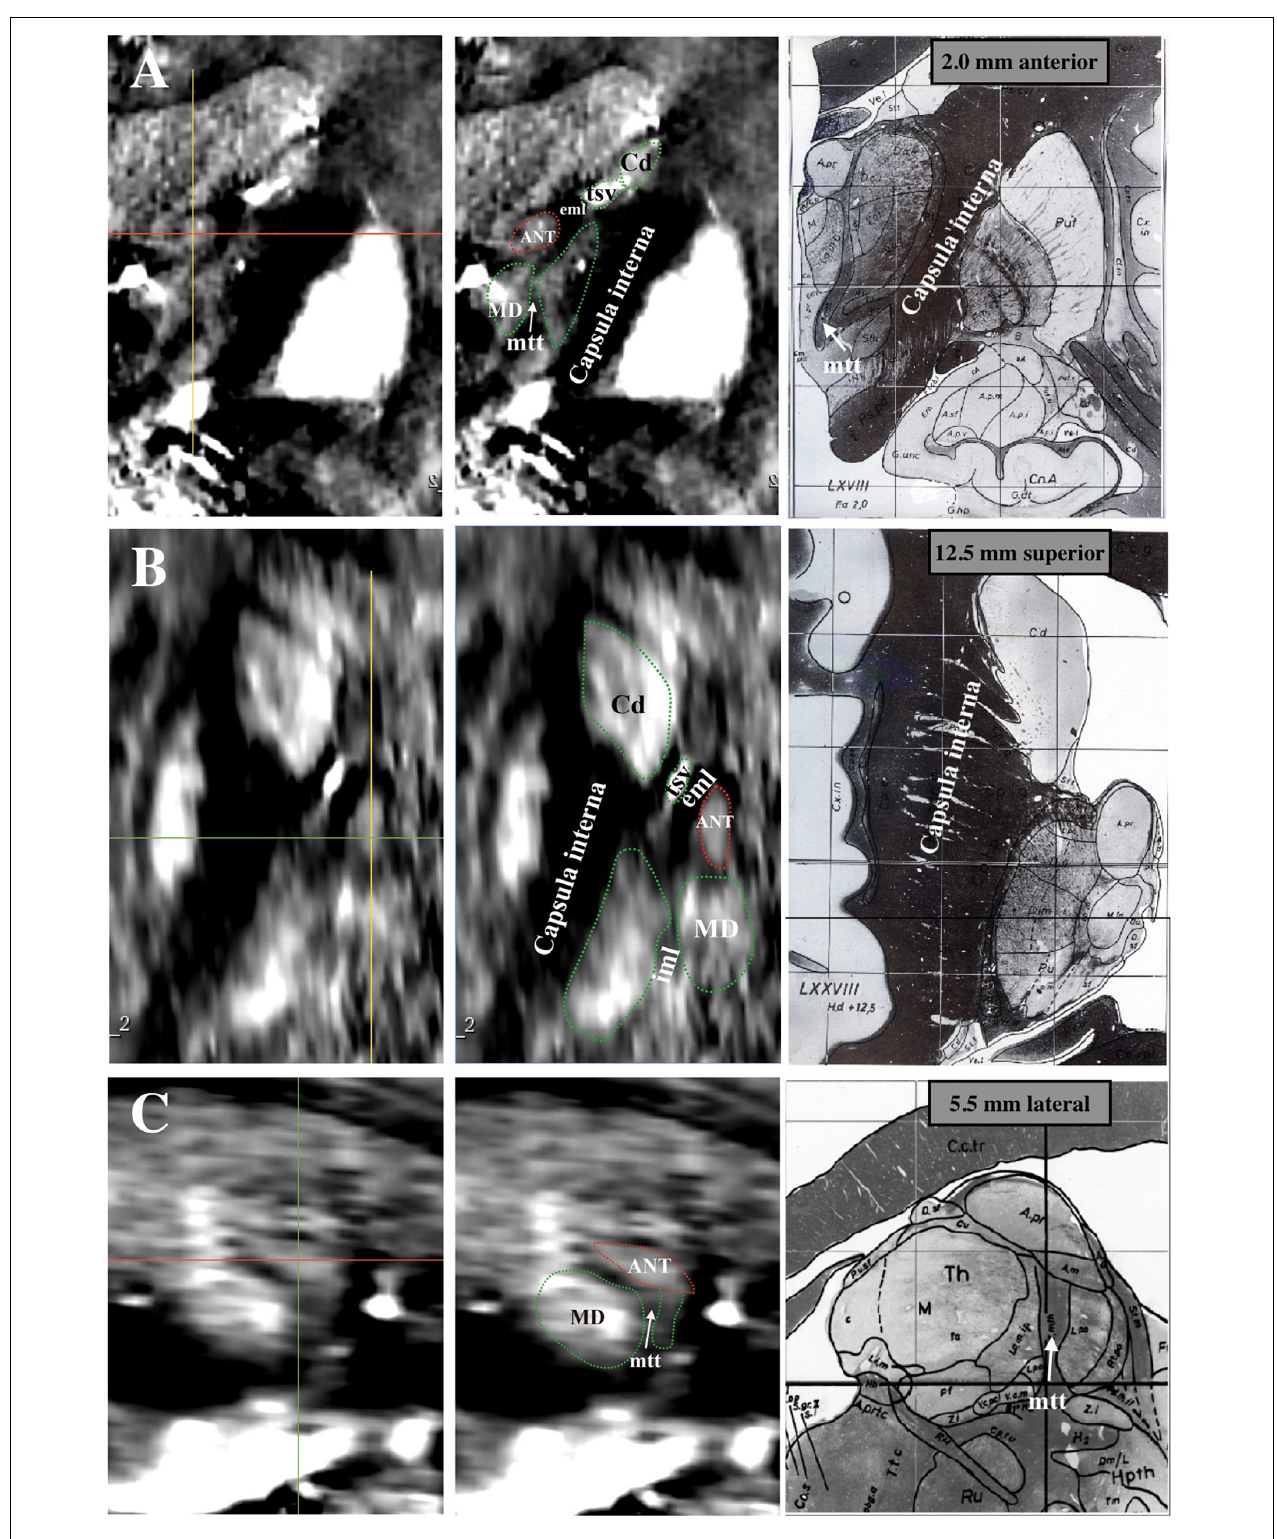
FIGURE 2 | Comparison between Schaltenbrand and Wahren histologic atlas (slices: 5.5 mm lateral; 2.0 mm anterior; 12.5 mm superior) and 3 T QSM. (A) Coronal orientation. (B) Axial orientation. (C) Sagittal orientation. ANT, anterior nucleus of the thalamus; eml, external medullary lamina; iml, internal medullary lamina; mtt, mammillothalamic tract; tsv, thalamostriate vein; Cd, caudate nuclei; MD, mediodorsal nucleus; QSM, quantitative susceptibility mapping.